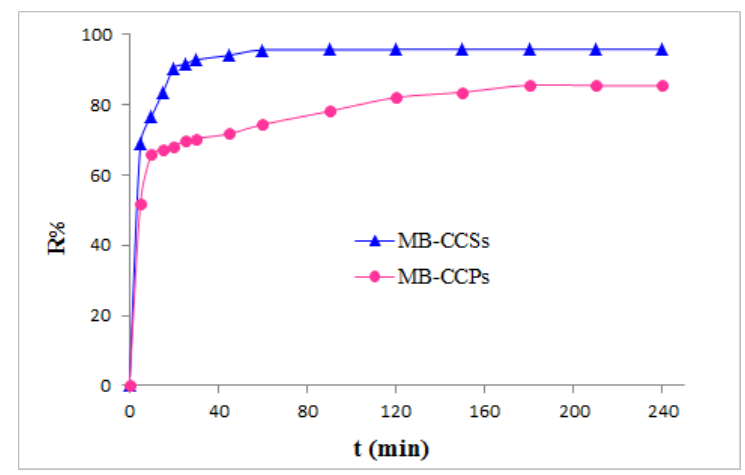
Figure 4. Effect of contact time on MB dye removal efficiency using CCSs and CCPs.